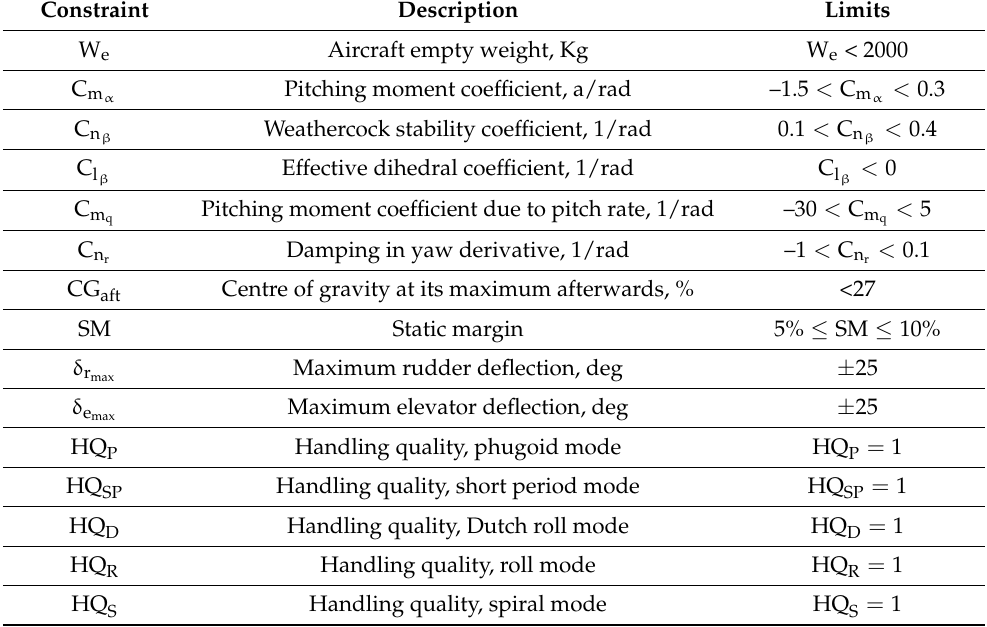
Table 4. The list of constraints considered for the size of the empennage model.